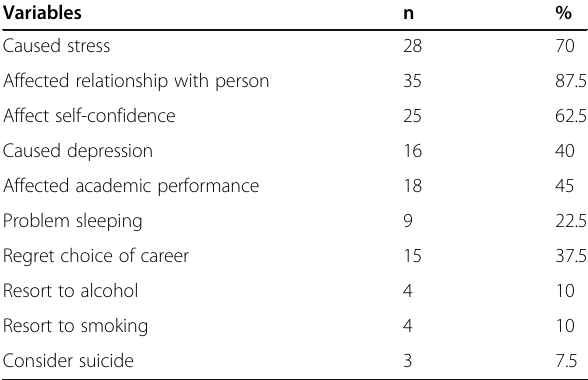
Table 3 The effects of the mistreatment on the participants